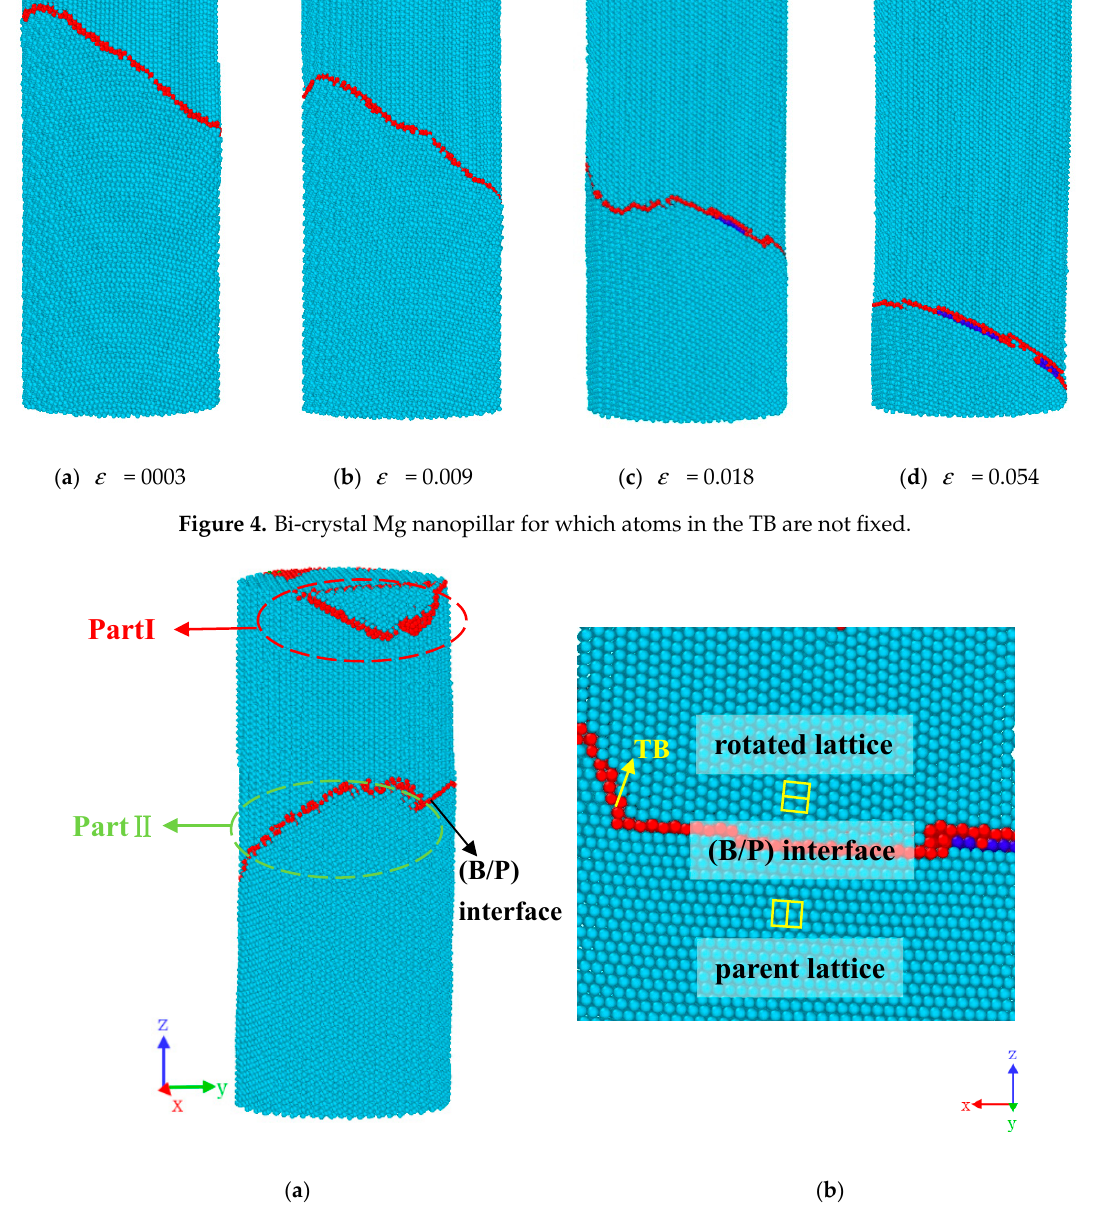
Figure 5. ( a ) Configurations shown for the TB migration at the compressive strain of 0.047. ( b ) A magnified picture of basal/prismatic (B/P) interface.